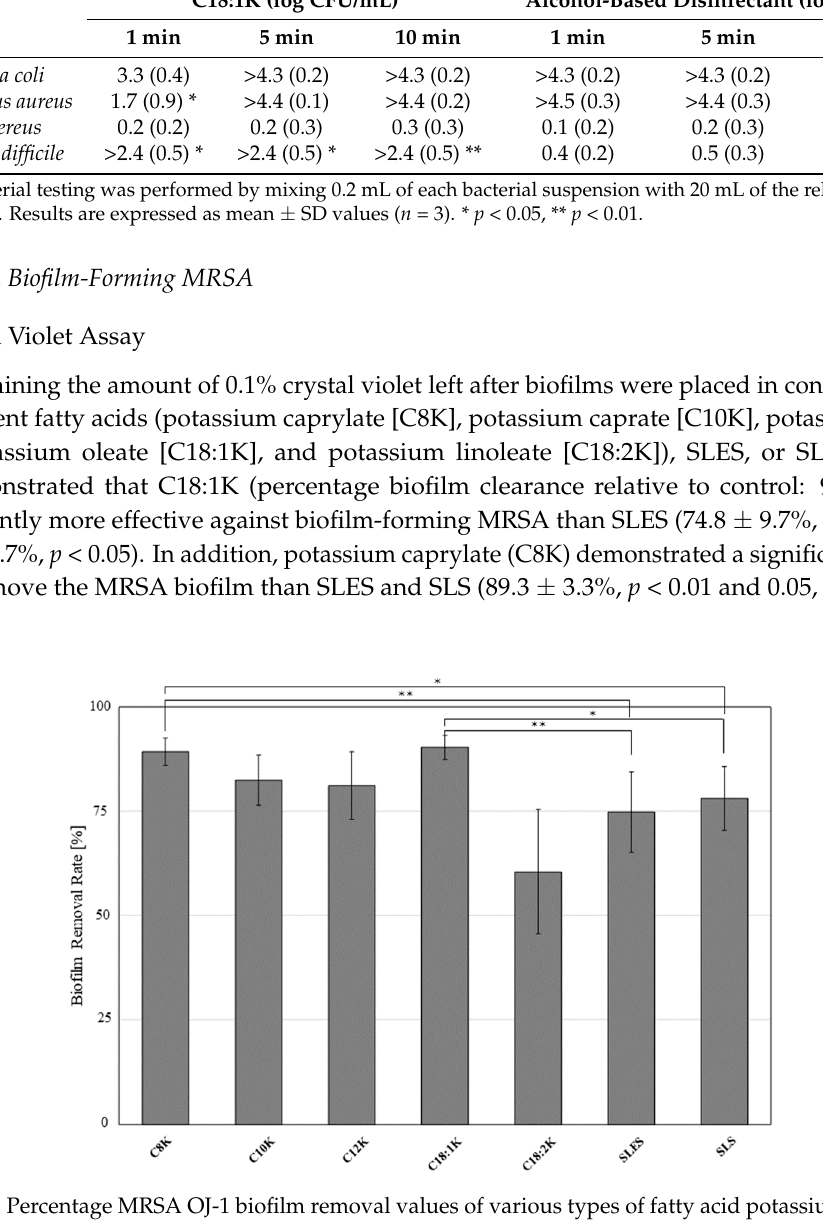
Figure 6. Percentage MRSA OJ-1 biofilm removal values of various types of fatty acid potassium, SLES, and SLS. The formed biofilm was placed in contact with the test substance for 1 min. The biofilm remaining in the well was stained with 0.1% crystal violet and quantified based on the absorbance at 570 nm using a microplate reader. The results are expressed as mean ± SD values ( n = 6). * p < 0.05, ** p < 0.01.